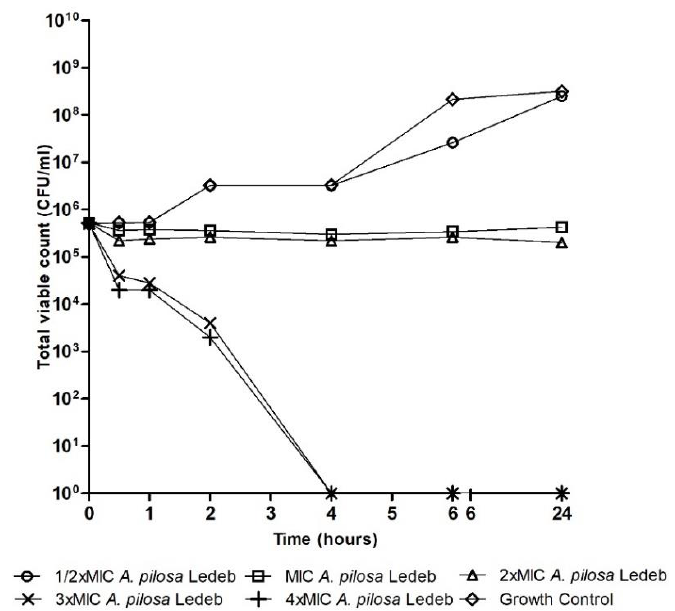
Figure 2. Total viable count of endogenous and inoculated E. coli UM004, UM011, and UM012 mixture in the presence of Agrimonia pilosa Ledeb.